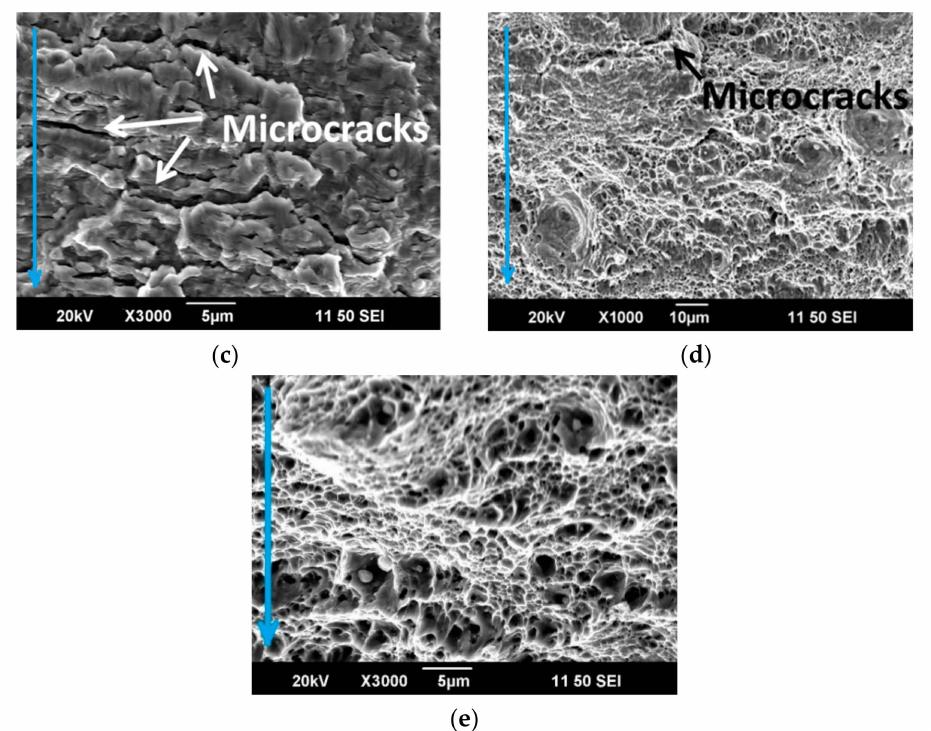
Figure 8. The fracture surface after CR + requenching in the sections: ( a ) zone 1; ( b , c ) zone 2; ( d , e ) zone 3. SEM images. The blue arrows indicate the direction of crack